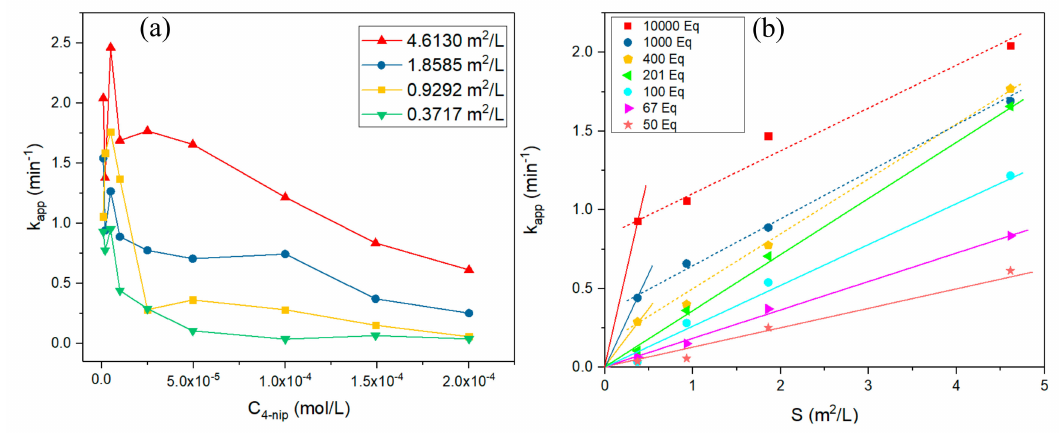
Figure 6. Plots of k app versus ( a ) the concentration of 4-nitrophenol at a constant temperature of 22.4 ◦ C and concentration of NaBH 4 of 1 × 10 − 2 M for four di ff erent surface areas of NPs Pd, 0.3717 m 2 / L, 0.9292 m 2 / L, 1.8585 m 2 / L, and 4.6130 m 2 / L. ( b ) Surface area of Pd NPs at a constant temperature of 22.4 ◦ C for seven di ff erent equivalents of NaBH 4 10,000 eq, 1000 eq, 400 eq, 201 eq, 100 eq, 67 eq, and 50 eq. The straight lines illustrate the intrinsic kinetic area, and the dashed lines illustrate the area where di ff usion limitations take